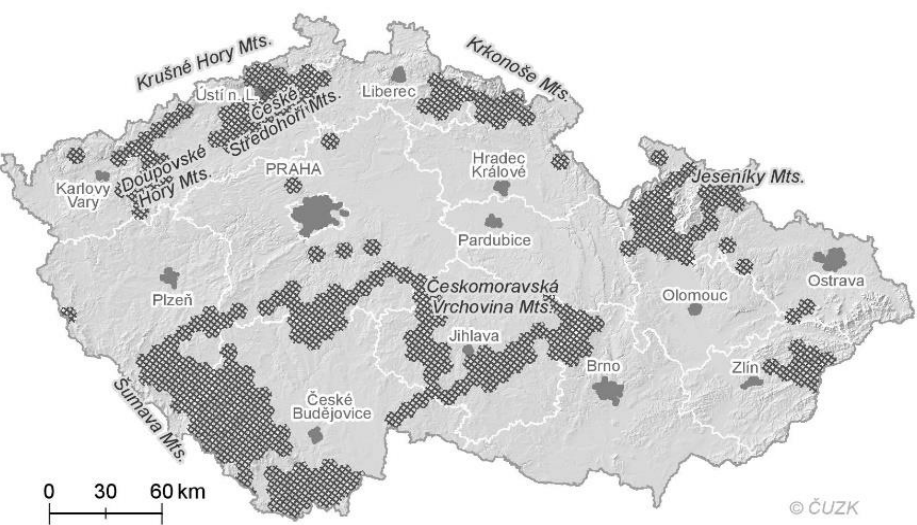
Figure 3. Spatial distribution of historical agricultural landforms in Czechia — dark hatched patches represent regions with more than one HAL per km 2 — visualized as density within 5 km 2 grid [data sources: ArcČR 500 database, ZABAGED®— Altimetry —DMR 5G, ČÚZK, Praha, Czech Republic, own HAL presence geodatabase; processed in ArcGIS, ESRI, Redlands, CA, USA].